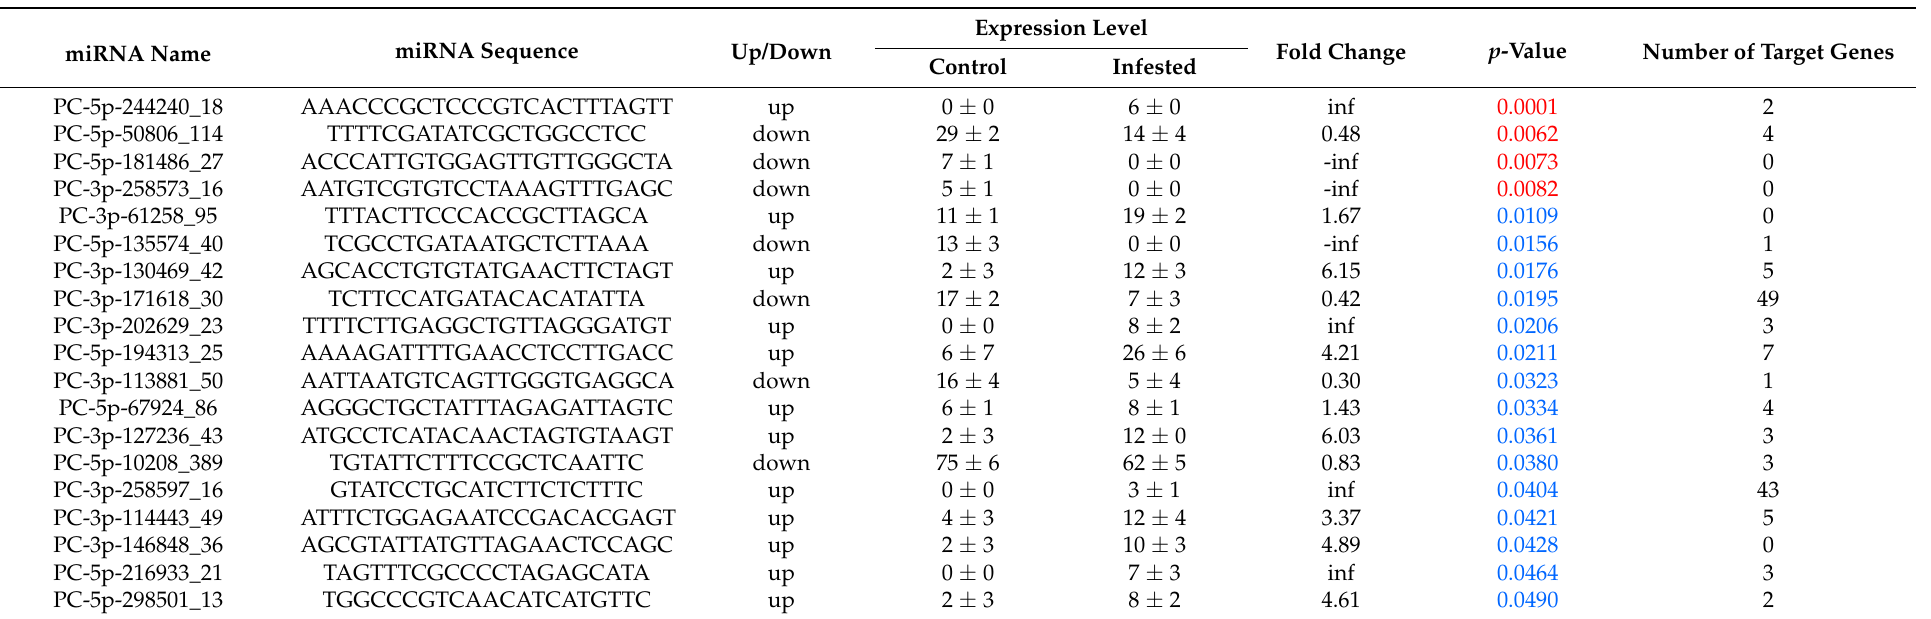
Table 3. Summary table of differentially expressed novel miRNAs. Control and Infested show the expression of miRNAs after normalization (mean ± SD). Fold change was obtained by dividing the mean of the expression of Infested group by the mean of Control. Inf means the miRNA was only expressed in Infested, and -inf means the miRNA was only expressed in Control. Statistical significance was evaluated using Student’s t test. p values colored red were evaluated at p < 0.01, and blue at p <